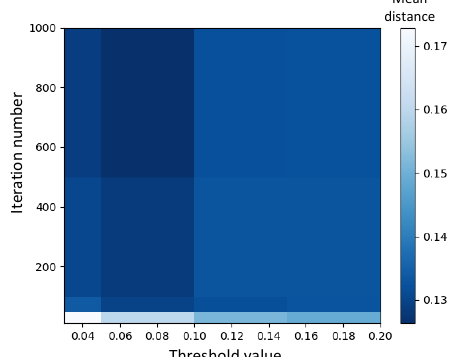
Figure 8 Results of the experiments with RANSAC